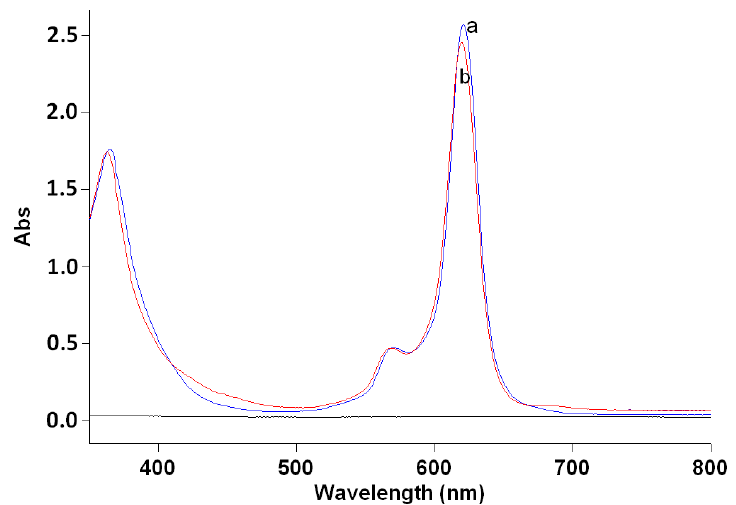
Figure 1. UV–Vis spectra in chloroform: ( a ) Mg(II)-octa-(2,6-difluorophenyl)tetraazaporphyrin; ( b ) Zn(II)-octa-(2,6-difluorophenyl)tetraazaporphyrin (c ~1.7 × 10 − 5